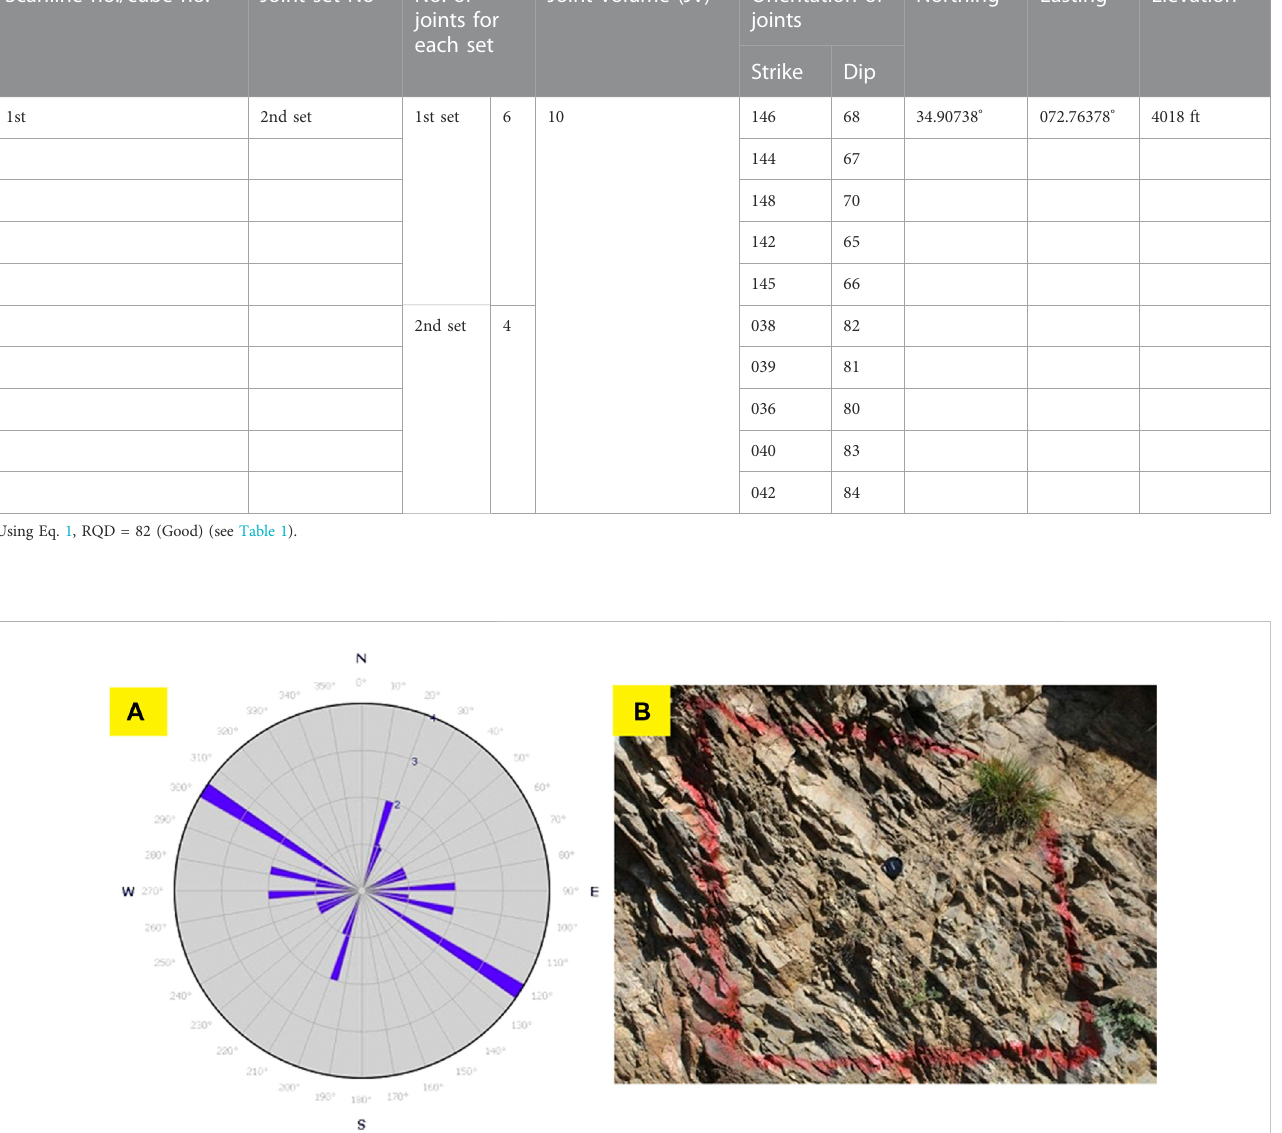
TABLE 4 JV, strike and dip data, and geographic coordinates of low joint density rocks. Scanline no./cube no.